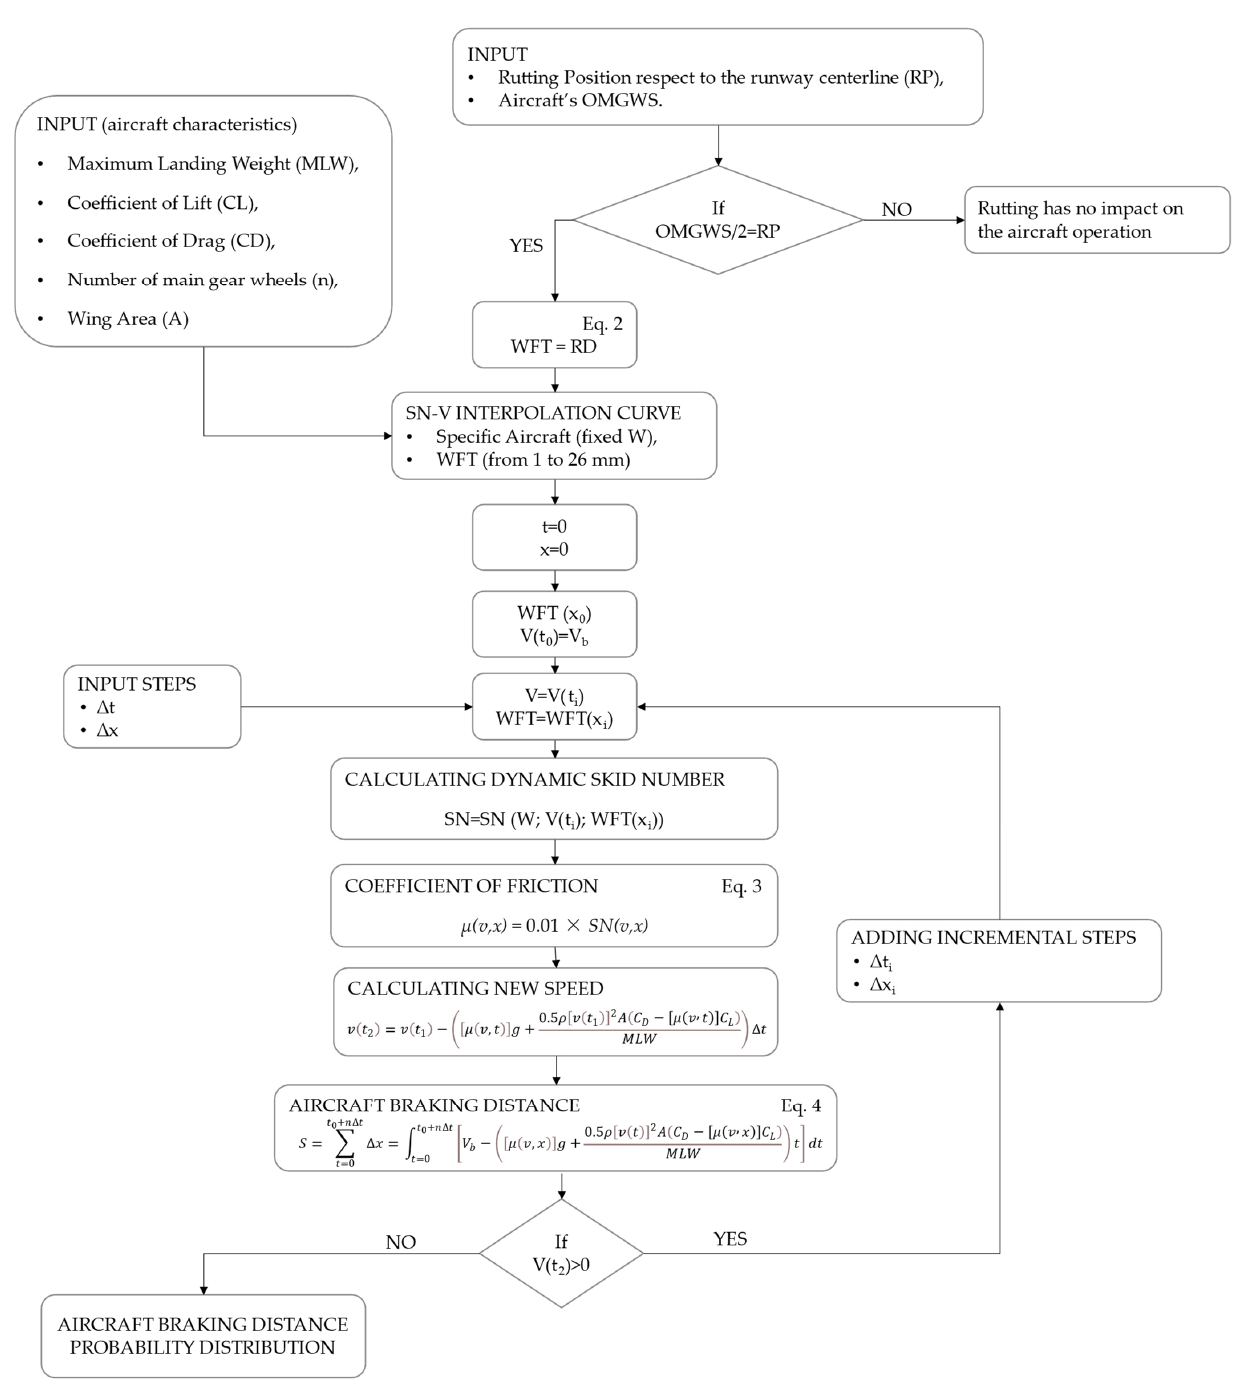
Figure 4. The algorithm of the aircraft braking distance calculation model.